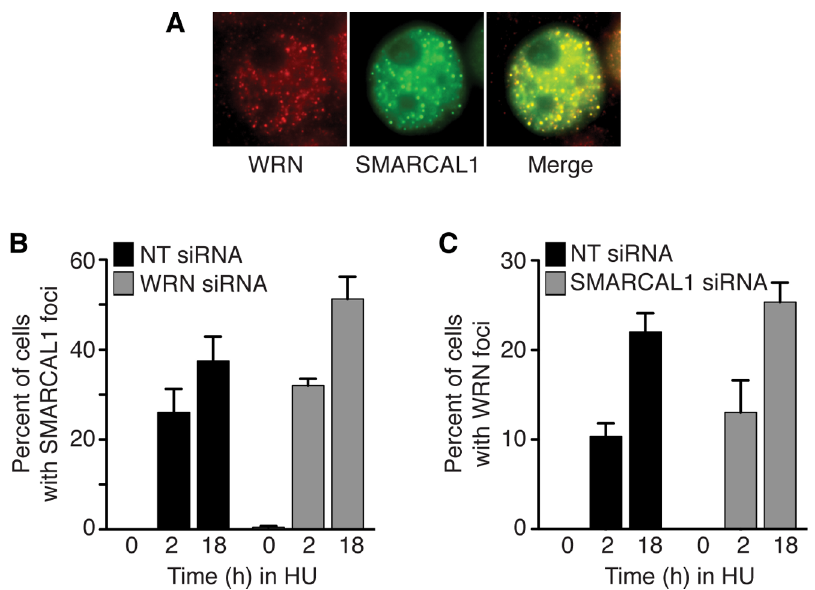
Figure 2. SMARCAL1 and WRN co-localize at stalled replication forks. (A) HeLa cells expressing GFP-WRN were treated with 2 mM HU, fixed, and stained with antibodies to SMARCAL1. (B) HeLa cells were transfected with non-targeting (NT) or WRN siRNAs then treated with 2 mM HU for the indicated times. Cells were fixed and stained with antibodies to SMARCAL1. (C) GFP-WRN expressing HeLa cells were transfected with NT or SMARCAL1 siRNAs, treated with 2 mM HU for the indicated times, fixed, and imaged for WRN. No significant difference is observed between the NT and SMARCAL1 siRNA samples.